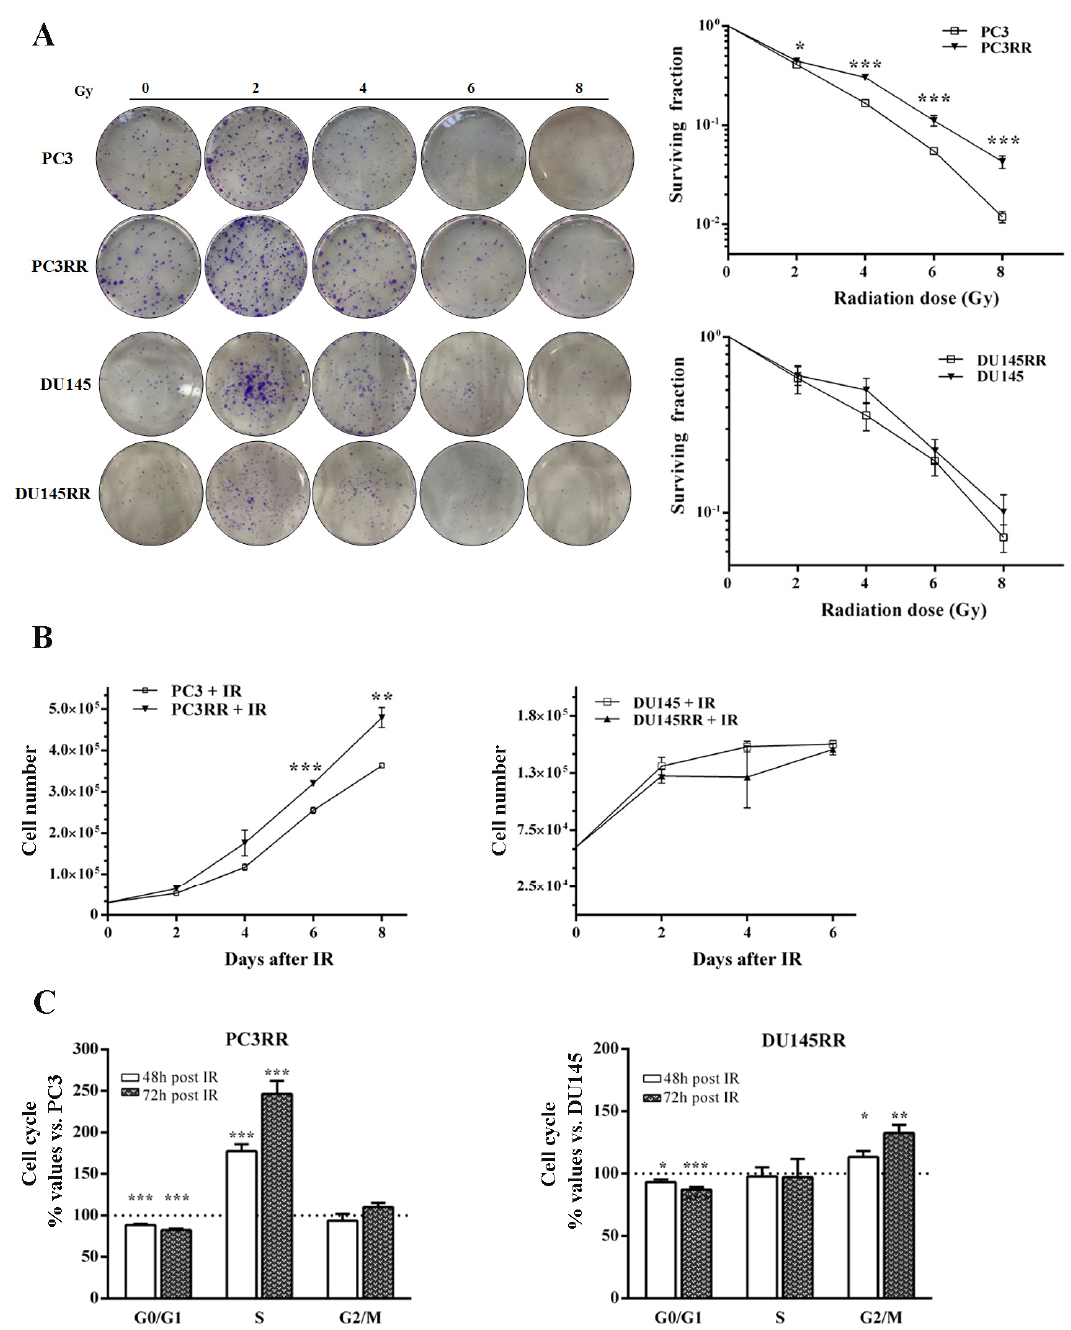
Figure 2. Clonogenic and proliferation assays of parental PCa and PCaRR cell lines. ( A ) Clonogenic assay of the radioresistant cells PC3RR, DU-145RR, parental PC3 and DU-145 cell lines with increasing doses of radiation (2, 4, 6, 8 Gy). Colony was obtained after 11 days of culture post-radiation and stained with crystal violet. The micrographs of the colony formation ability represent plating at 200 and 800 cells/well for the control and IR-treated cells, respectively. The graph shows the surviving fraction after increasing doses of radiation, defined as: n° of colonies formed after IR/n° of cells seeded × plating efficiency (PE). ( B ) Proliferation analysis using cell counting of both PCa and PCaRR cell lines at indicated times after IR at 4 Gy. ( C ) Evaluation of cell cycle distribution at the indicated times after IR at 4 Gy. Data are expressed as the mean ± S.E.M. derived from at least three independent experiments. Statistical significance: * p < 0.05; ** p < 0.01; *** p < 0.001. PC3RR vs. PC3 and DU-145RR vs. DU-145 Student’s unpaired t -test.